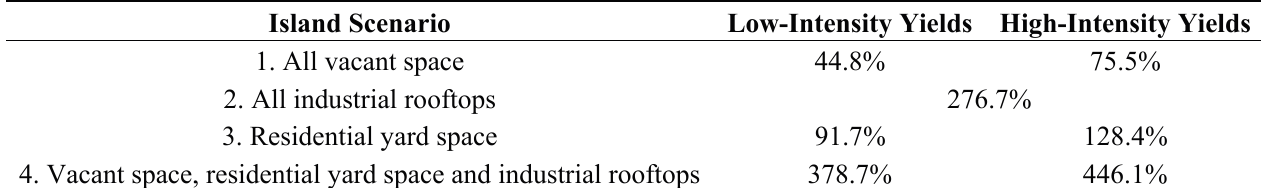
Table 3. Four simulation scenarios expressing the percentage of vegetable demand met on the entire island of Montréal using either a low or a high estimate for urban agriculture (UA)